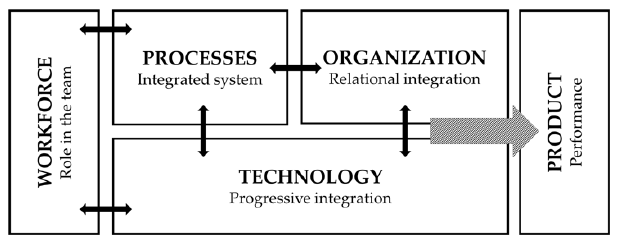
Figure 2. Integrated construction environment. Adapted from [31].